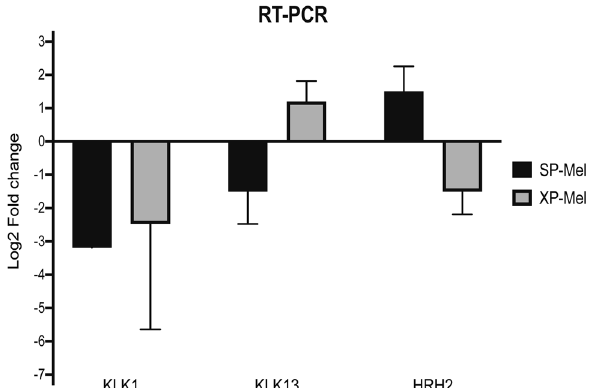
Figure 2. Validation of randomly selected inflammatory genes by RT-qPCR . Data are represented as Log2 fold change. Results are presented as mean ± standard error for RT-qPCR normalized to 2 housekeeping genes RPLP0 and PPIA (mean of triplicate analyses for XP-Mel (n = 3) and SP-Mel (n = 3).